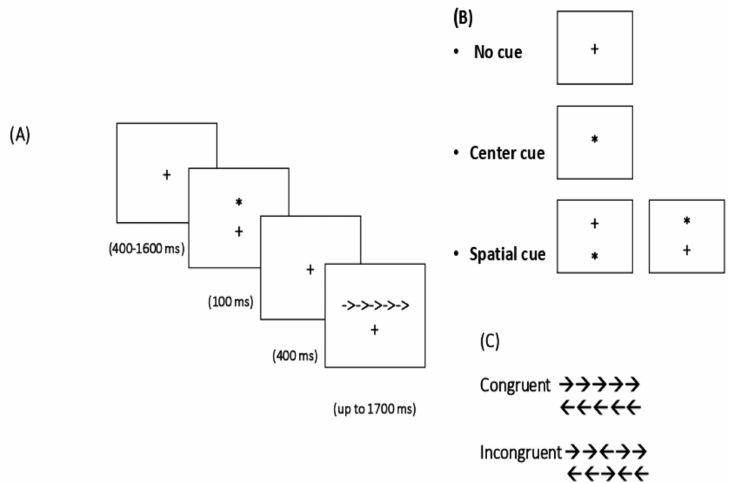
Figure 1. Example trial in the attention network test (ANT): The sequence of events for a trial with spatial cue for congruent trial ( A ), cue conditions ( B ), flanker type ( C